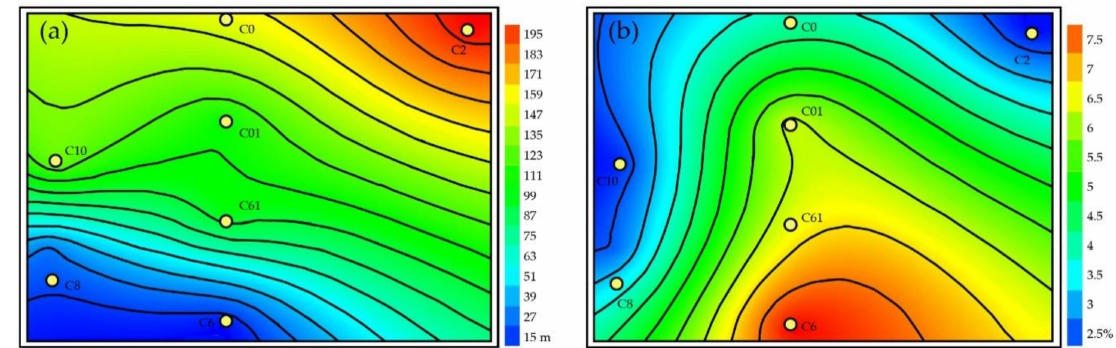
Figure 6. ( a ) Averaged reservoir thickness contour map. ( b ) Averaged porosity contour map. The data correspond to Table 3. The well testing data from a depth interval of 3356.2 m to 4552 m show that the porosity ranges from 0.1% to 10.6% and the permeability from 0.1 to 5.535 milli-darcy (abbreviated to mD) (Figure 7; Table 4), suggesting generally poor physical properties of the layers from the Es 3 L Formation in this region. However, two positive anomalies were found from 3700–3800 m and 4100–4300 m intervals (Figure 7), suggesting improved physical